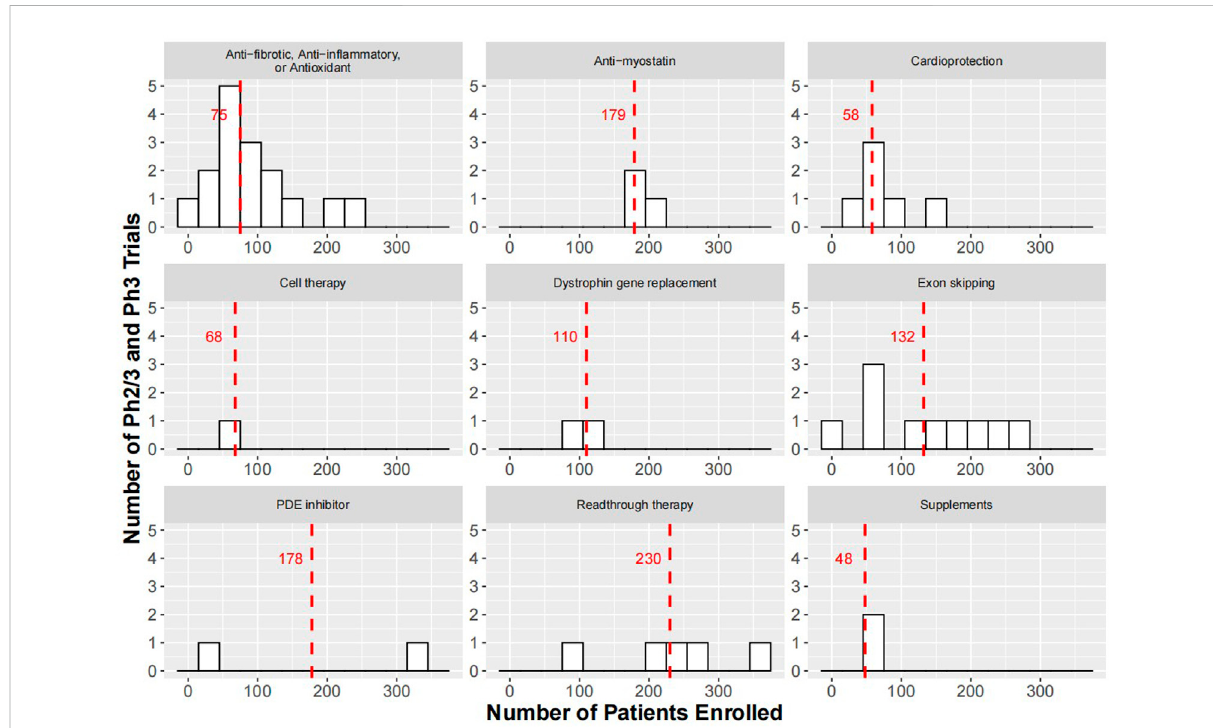
FIGURE 1 Histograms showing enrollment sizes for Ph2/3 and Ph3 trials of therapeutic strategies for the treatment of DMD. Red dashed lines indicate medium enrollment size for trials within each therapeutic strategy. For study start and anticipated study end date of the trials please refer to SupplementaryTableS2.Incelltherapy,therewasapivotalPh3study(HOPE-3,NCT05126758)withanexpectedcompletionin2024toevaluatethe safety and ef fi cacy of CAP-1002 in 68 DMD patients. The smaller than expected sample size may be based on the anticipated effect size and variability in the primary endpoint, change in full Performance of the Upper Limb test version 2 (PUL 2.0) at Month 12, which achieved signi fi cance in 20 participants (12 placebo and 8 treated) enrolled in the Ph2 trial (HOPE-2, NCT03406780) (Capricor, 2021).